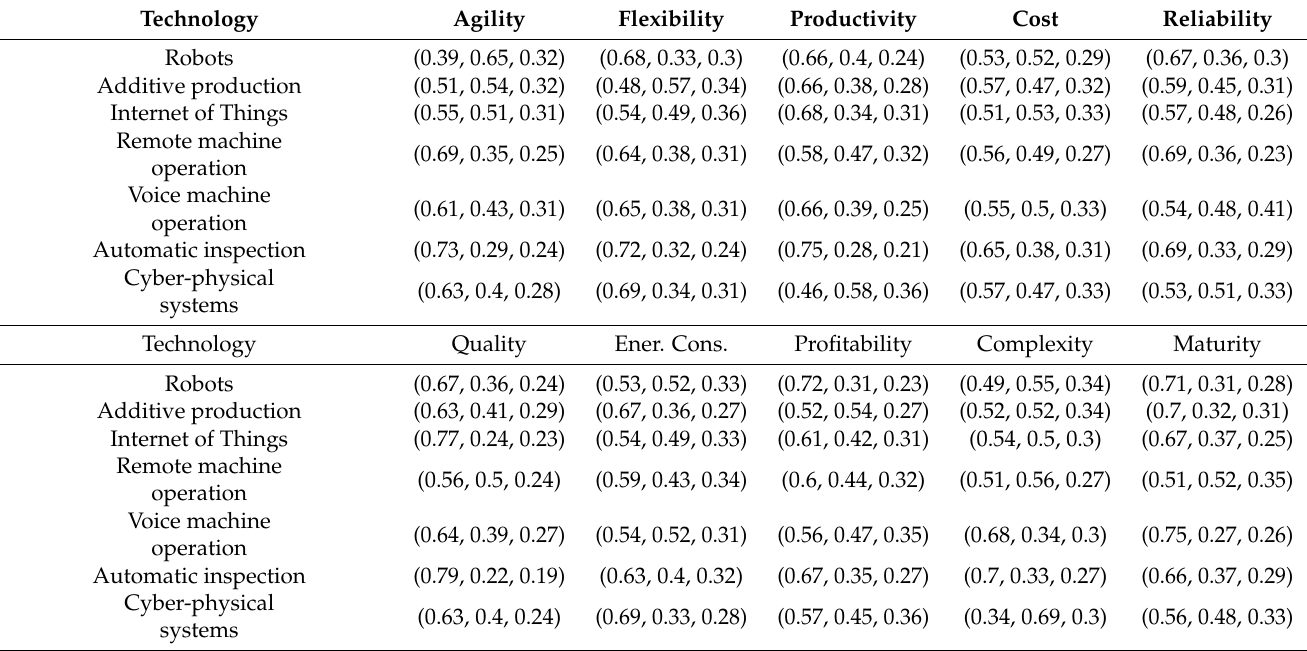
Table A4. The SF decision